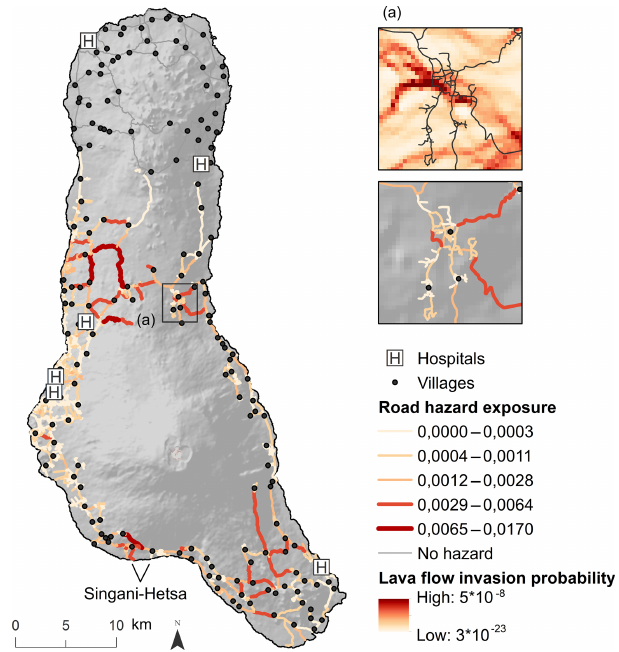
Figure 7. Road hazard exposure map for the Karthala volcano showing susceptibility to lava flow hazard for each road segment with an inset on Koimbani. The upper inset represents the lava flow hazard probability map in the surroundings of Koimbani. Roads are overlaid on top of the hazard map. The lower inset shows suscepti- bility values for road segments in Koimbani.